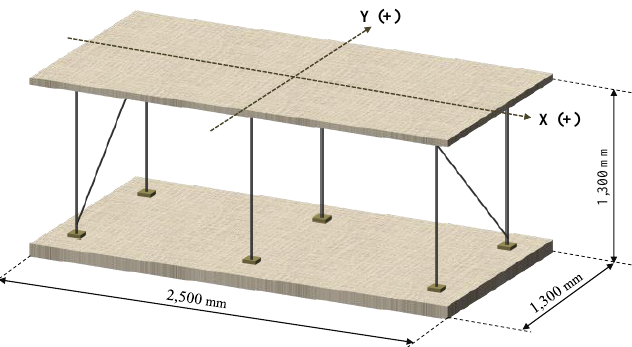
Figure 2. Experimental model.